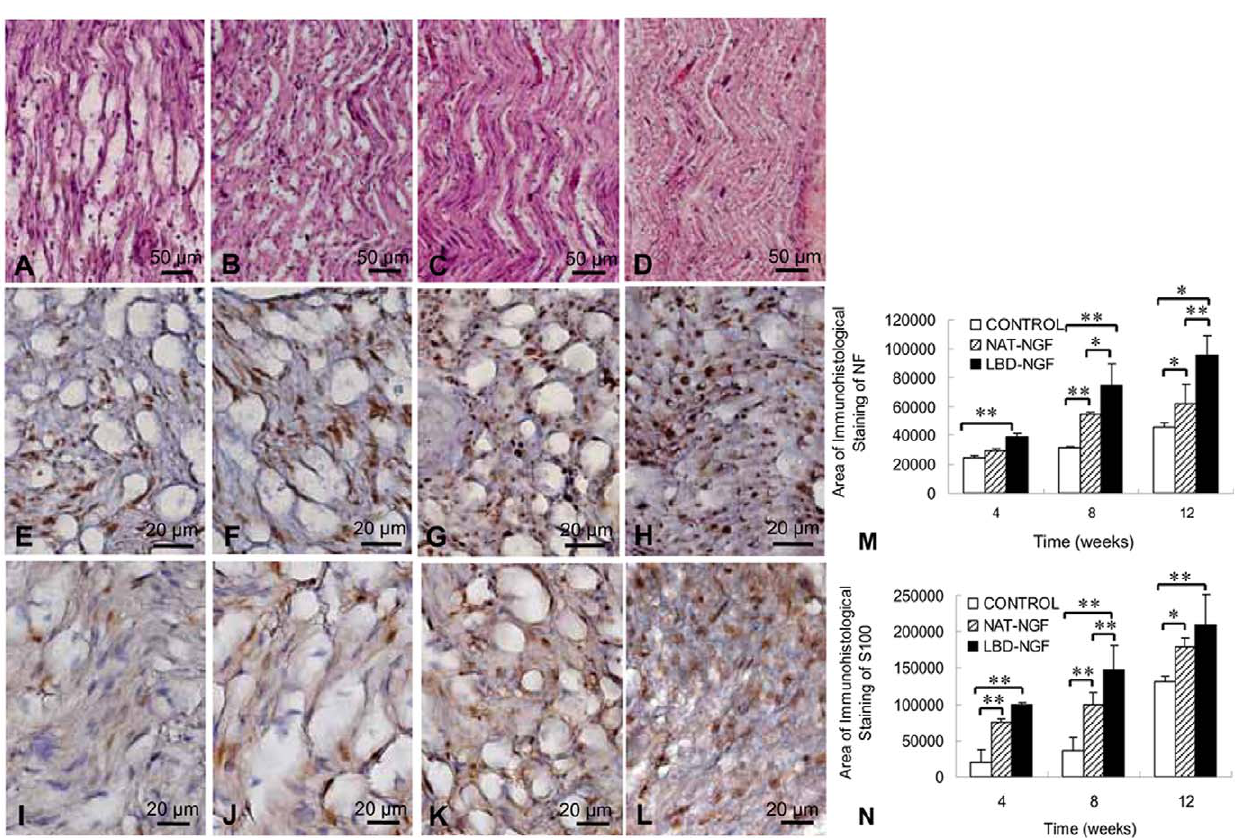
Figure 5. Histological analysis. (a–d) At week 8 after injury, the longitudinal sections of the control (a), NAT-NGF (b) and LBD-NGF group (c) compared with that of native nerve group (d) analyzed by H.E. staining. (e–h) At week 8 after injury, immunostaining with anti-neurofilament antibody in transverse sections of the control (e), NAT-NGF (f) and LBD-NGF group (g) compared with that of native nerve group (h). (i–l) At week 8 after injury, immunotaining of the Schwann cell marker S100 in the transverse sections of the control (i), NAT-NGF (j) and LBD-NGF group (k) compared with that of native nerve group (l). (m) The statistical analysis of neurofilament-positive area of each group. (n) The statistical analysis of S100-positive area of each group. n=6, *, P , 0.05, **, P , 0.01, determined by two-tailed student’s t -test.